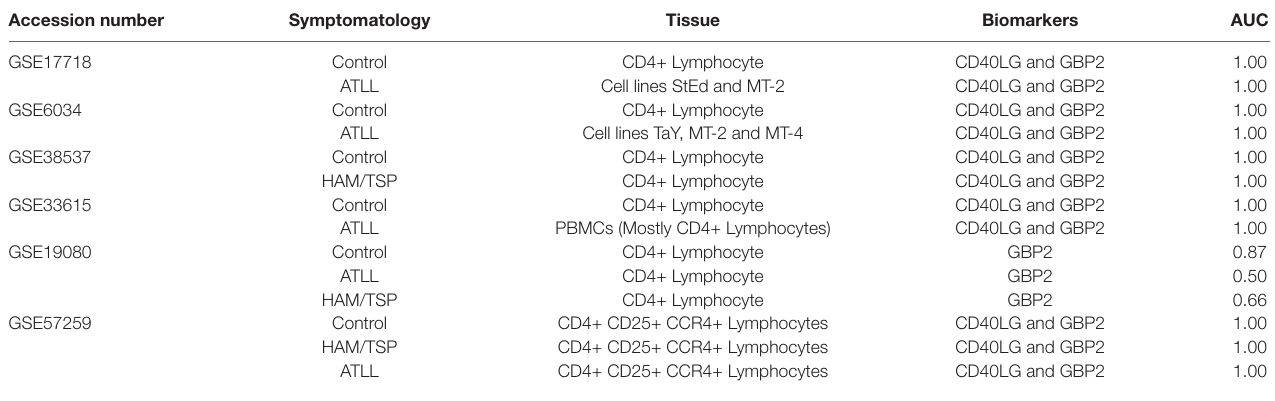
TABLE 2 | Performance of the two-gene signature classifying the samples from validation